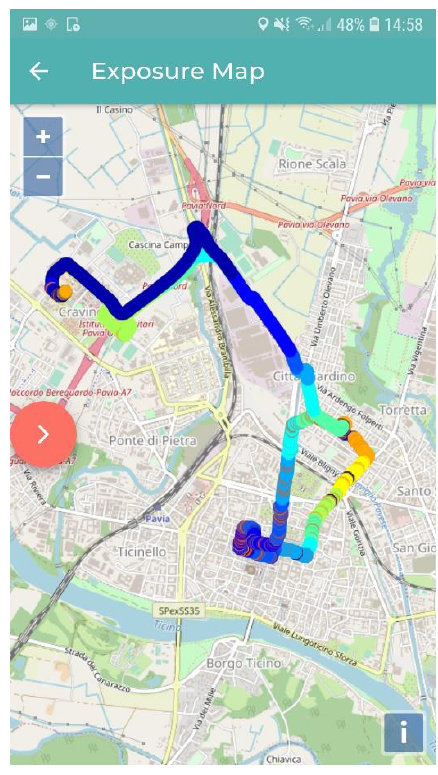
Figure 22. PULSEAIR App screenshot where personal expositor trajectory is visible